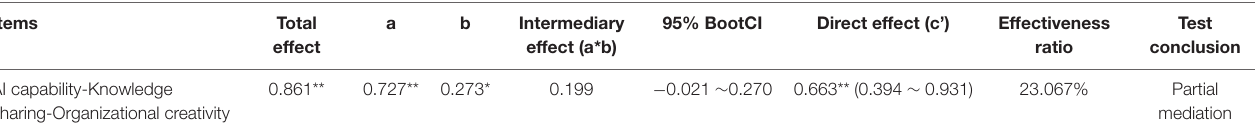
TABLE 8 | Summary of intermediary role test